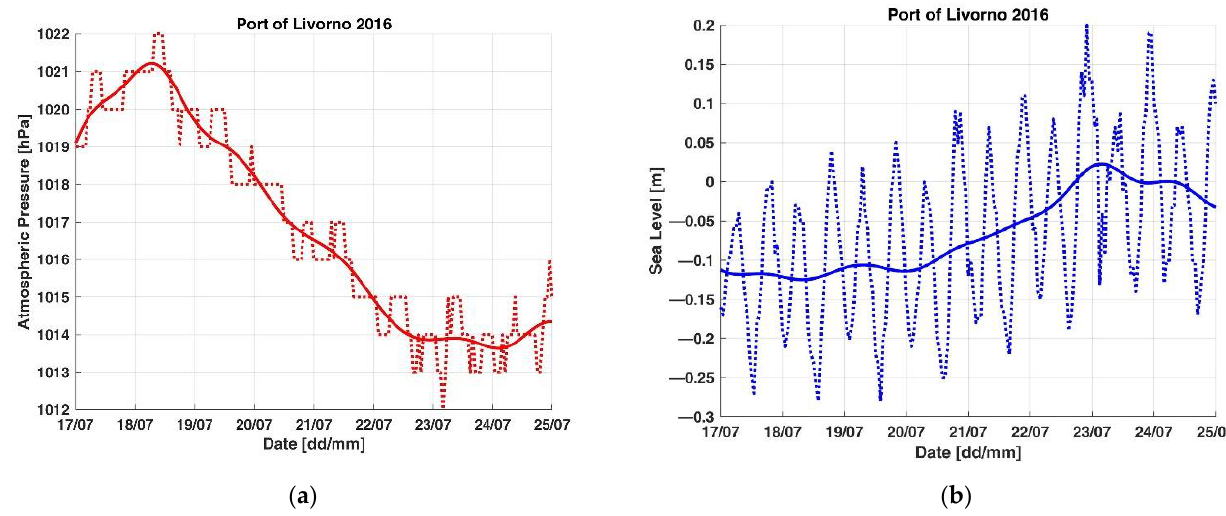
Figure A6. Low-frequency components of meteo-mareographic parameters acquired by ISPRA’s monitoring station in the port of Livorno from 17 to 25 July 2016 (atmospheric pressure data have been acquired with resolution of 1 hPa): ( a ) atmospheric pressure; ( b ) sea level.